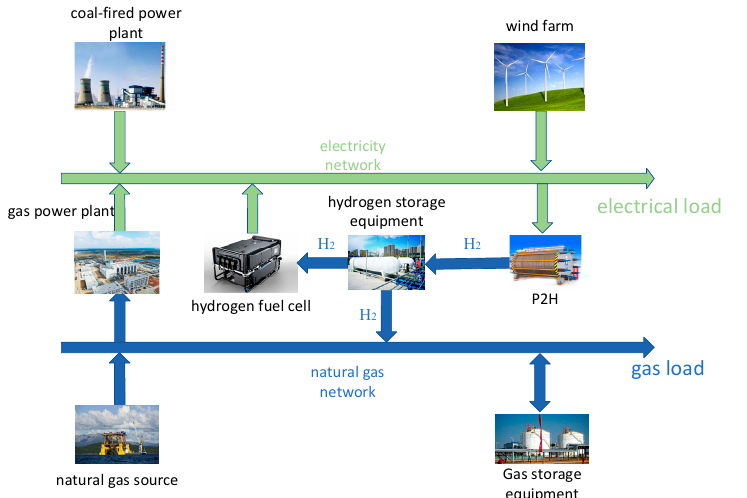
Figure 1. The structure of the EGIES considering HCNG. The green lines in the figure show the direction of the power flow from the power source to the power load, and the blue lines show the direction of the gas flow from the gas source to the gas load. “P2H” in the figure is the abbreviation of power-to-hydrogen, which means hydrogen production equipment by electrolysis of water.